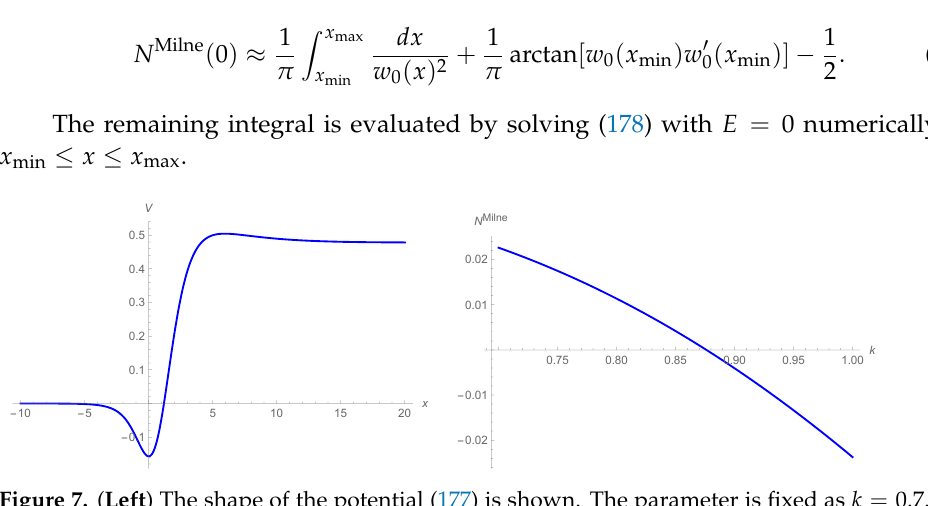
Figure 7. ( Left ) The shape of the potential (177) is shown. The parameter is fixed as k = 0.7. Our interest is to know whether this potential admits a bound state or not. ( Right ) This figure show Milne’s counting function for the black string potential (177). There is the critical value k c ≈ 0.876 at which the counting function changes its